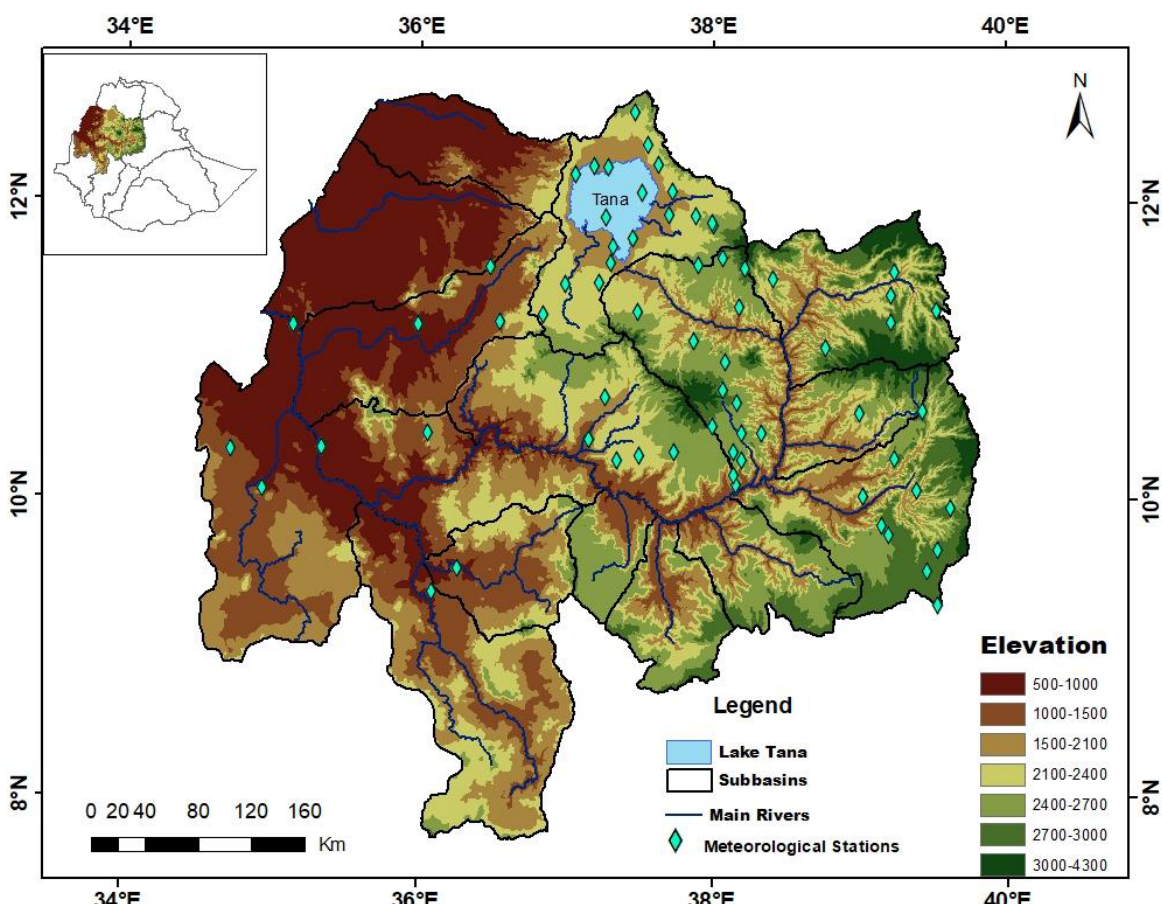
Figure 1. The geographical location of the Upper Blue Nile Basin ( Abay ) and meteorological station locations.